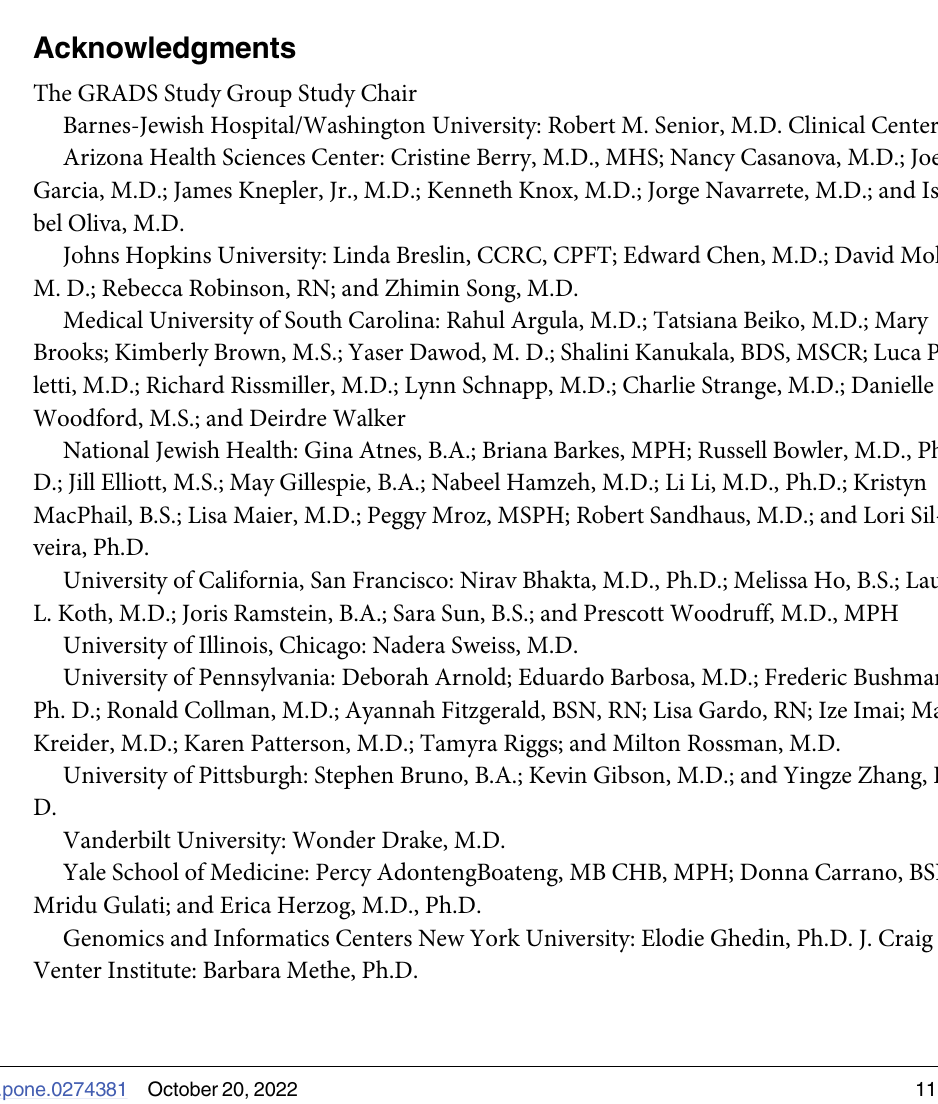
S1 Fig. The heatmap of 120 IgG autoantigen shows reactivity expressed in terms of row z- score for a respective antigen across different patient samples. Each row in the graphics rep- resent an antigen for serum specimens organized into columns classified as normal control (n = 101), extra pulmonary sarcoidosis (n = 120), and pulmonary only sarcoidosis (n = 106). The reactivity intensity ranges from blue (low) to white (moderate) or red (high). S2 Fig. The heatmap of 120 IgM autoantigen shows reactivity expressed in terms of row z- score for a respective antigen across different patient samples. Each row in the graphics rep- resent an antigen for serum specimens organized into columns classified as normal control (n = 101), extra pulmonary sarcoidosis (n = 120), and pulmonary only sarcoidosis (n = 106). The reactivity intensity ranges from blue (low) to white (moderate) or red (high). S3 Fig. 120 extra pulmonary sarcoidosis subjects were classified into 4 subgroups based on hierarchical cluster analysis, the optimal number of clusters by a hierarchical cluster analy- sis was determined by k-means